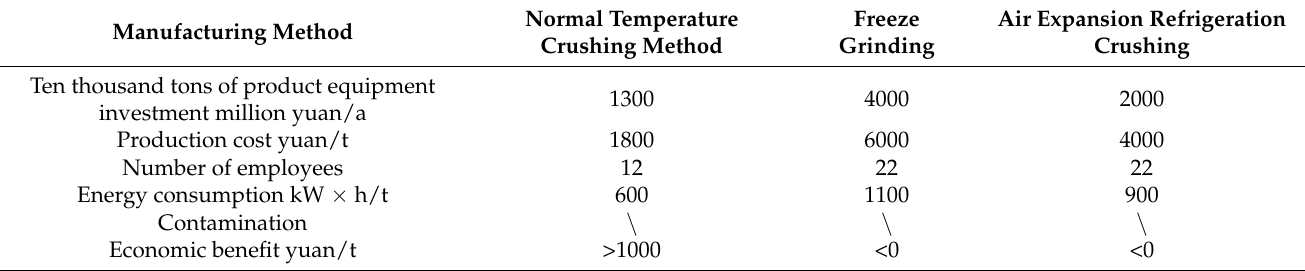
Table 12. Comparison of technical and economic indexes between normal temperature crushing method and low temperature crushing